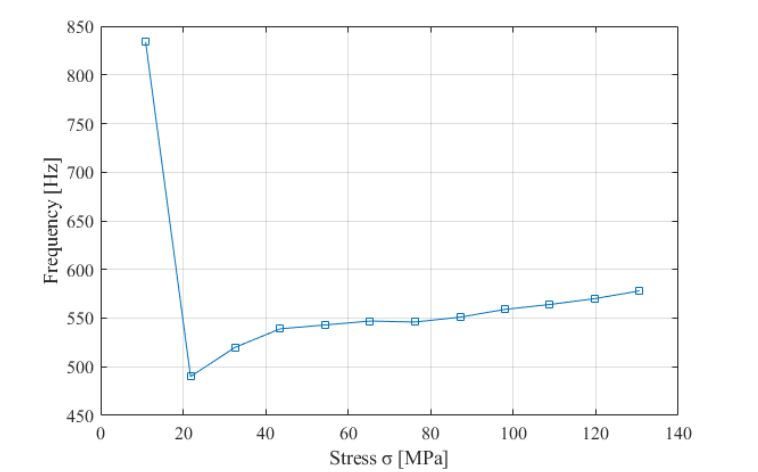
Figure 8. Graph of frequency dependence versus the given load with